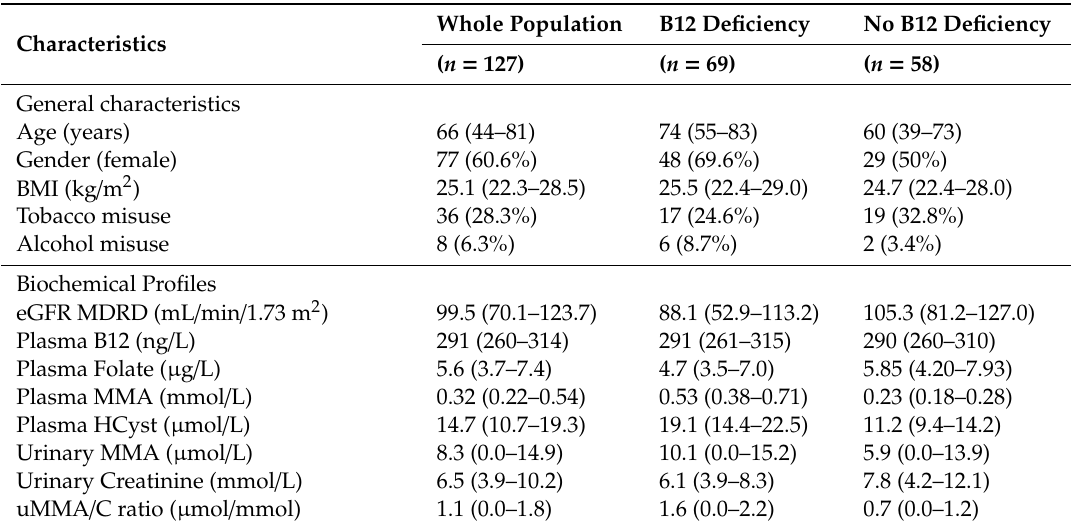
Figure 1. Flow chart of the study population. Table 1. Demographic and biological characteristics of the study population.